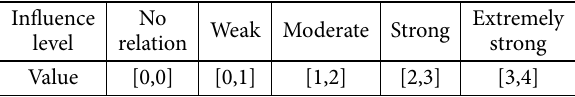
Table 2. Influence levels and respective interval